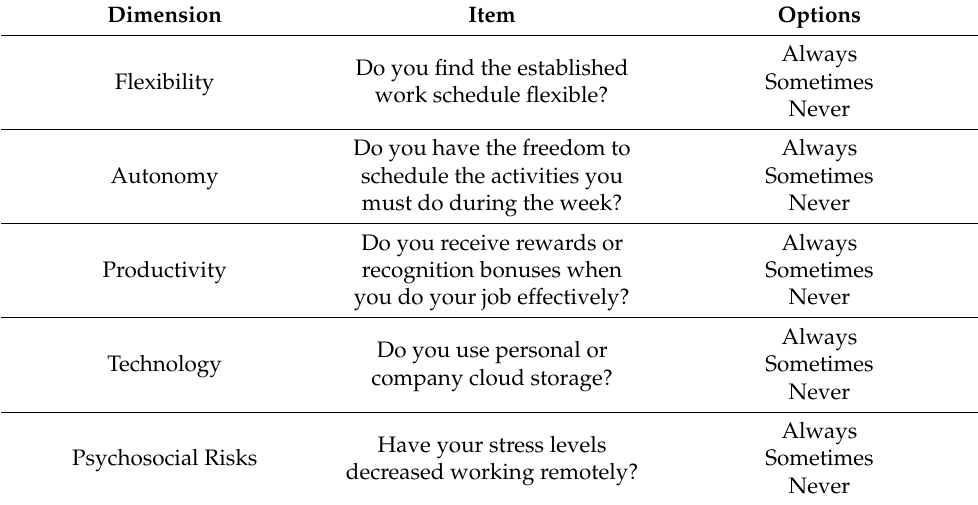
Table 3. Detail of the questionnaire: dimensions, items and response